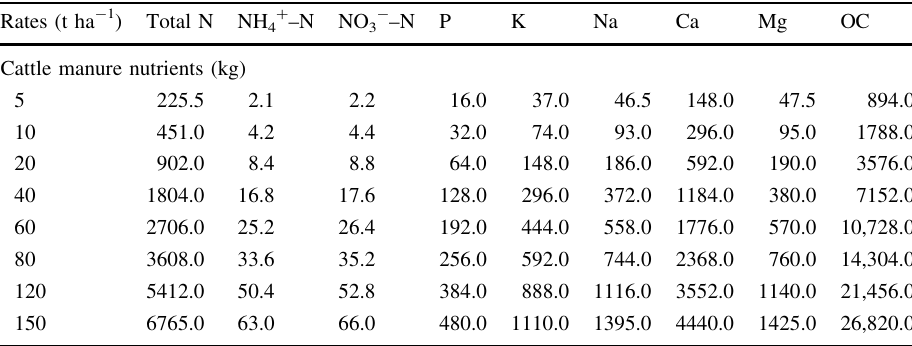
Table 2 Equivalent amount of nutrients present in cattle manure rates added to the soil